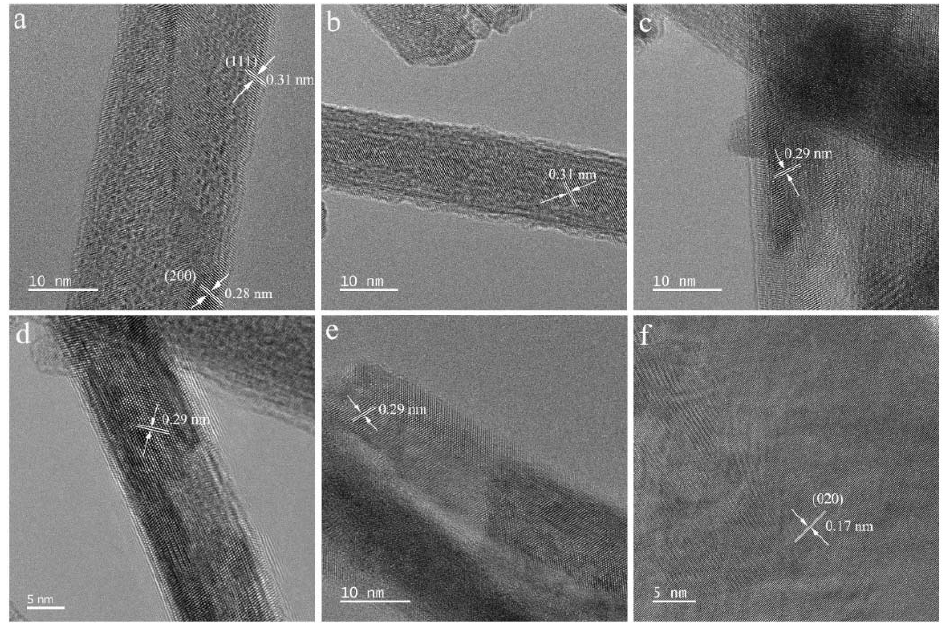
Figure 5. HRTEM images of the CuO/CeO 2 catalysts: ( a ) CeO 2 nr, ( b ) 10%Cu/Ce, ( c ) 20%Cu/Ce, ( d ) 50%Cu/Ce, ( e ) 80%Cu/Ce, and ( f ) CuO.